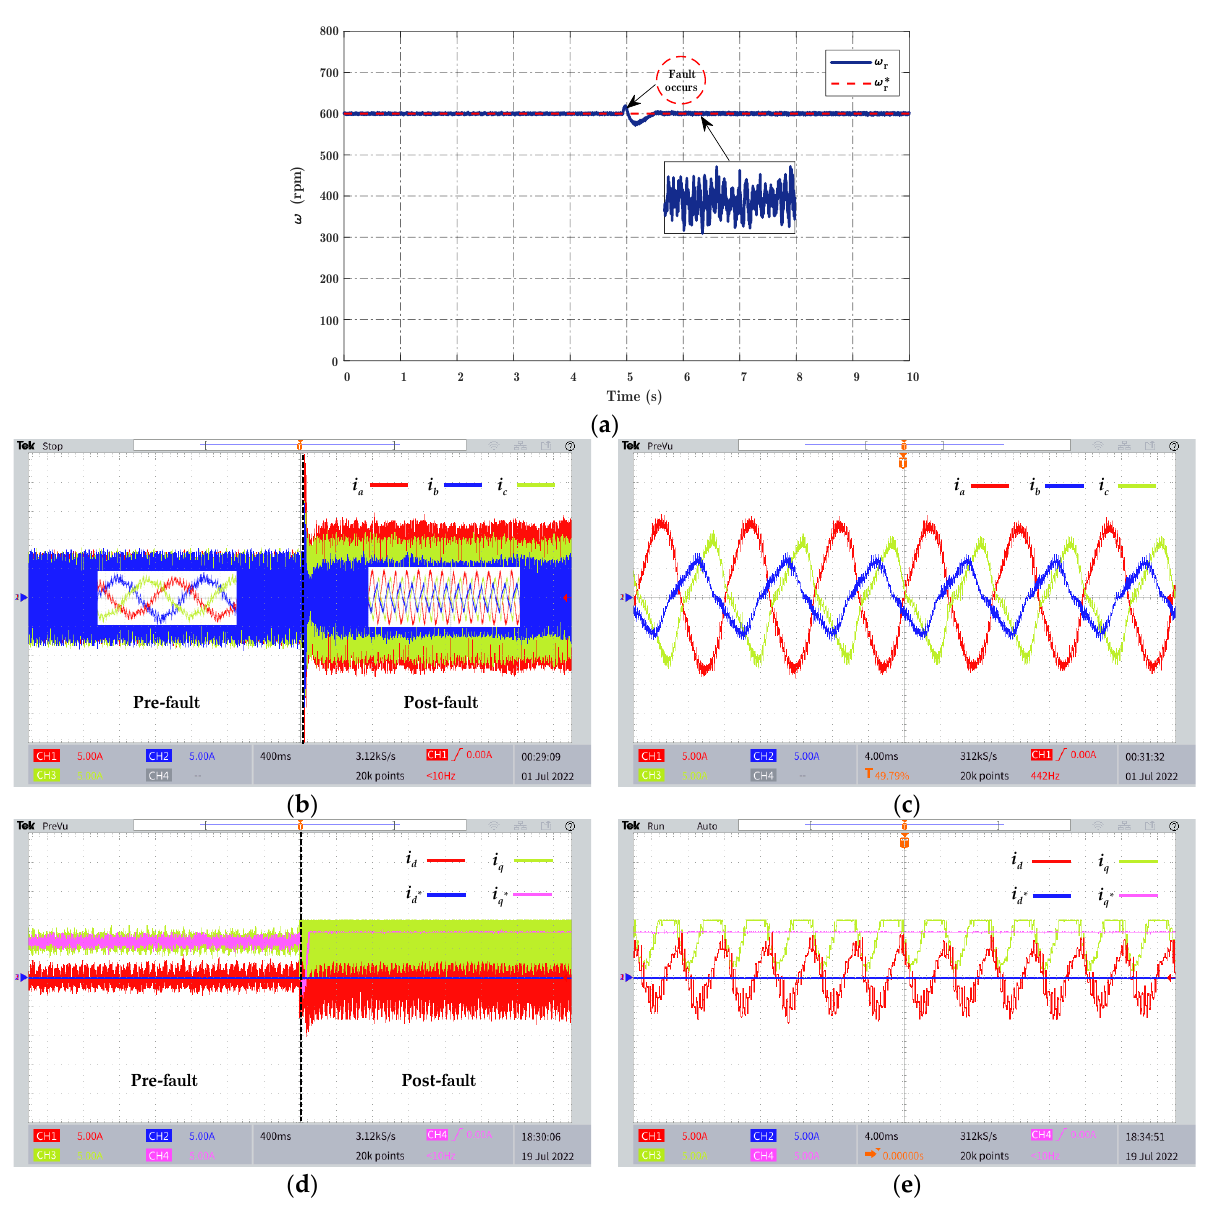
Figure 18. Electrical and mechanical characteristics in the faulty state with an LTs fault of 50%. ( a ) Rotor speed; ( b ) stator phase currents; ( c ) zoom of the stator phase currents; ( d ) direct and quadratic current component; ( e ) zoom of the direct and quadratic current component.